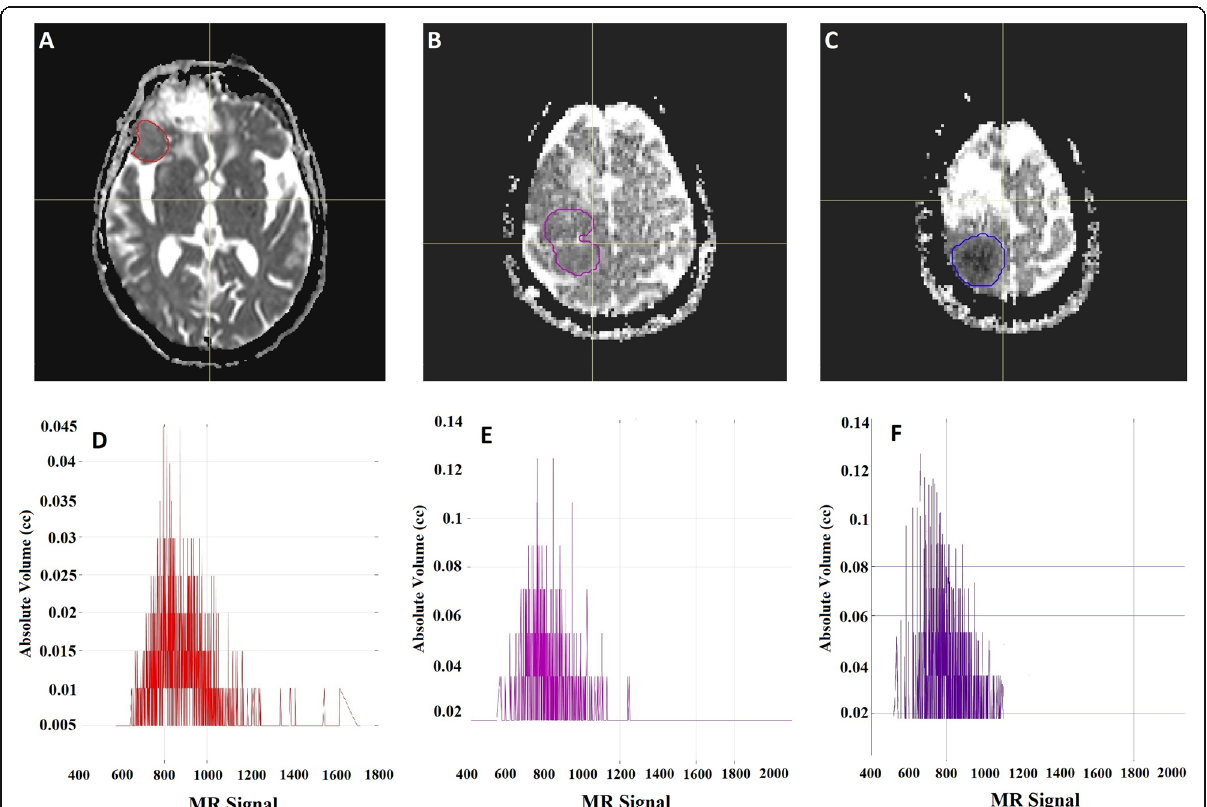
Fig. 1 The examples of MRI images and ADC histograms from different grades of meningioma tumors in one slice of brain. A An ADC image with grade I (contoured with red line). B An ADC image with grade II (contoured with purple line). C An ADC image with grade III (contoured with blue line). D A volumetric intensity histogram of grade I. E A volumetric intensity histogram of grade II. F A volumetric intensity histogram of grade